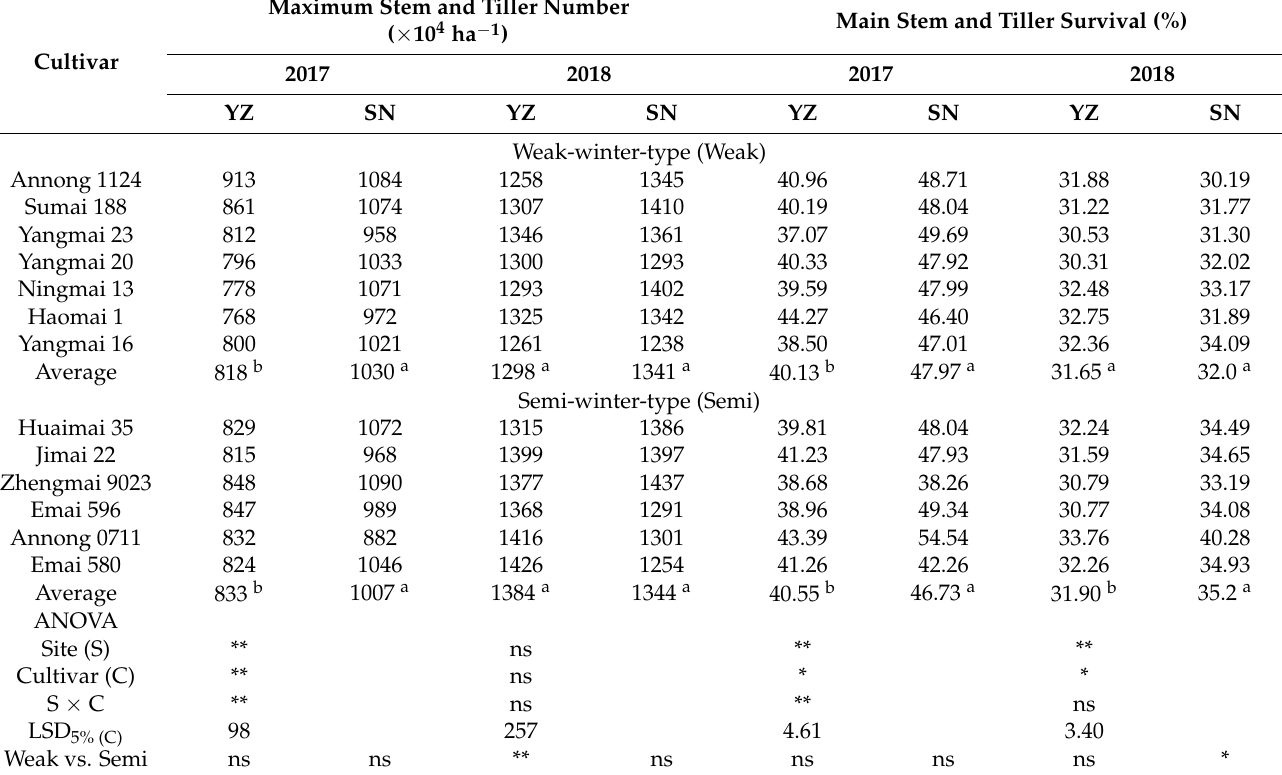
Table 6. Maximum stem and tiller number and main stem and tiller survival of weak-winter-type and semi-winter-type cultivars planted in southern (YZ, Yangzhou) and northern (SN, Suining) areas of the Yangtze River basin, China, in 2017 and